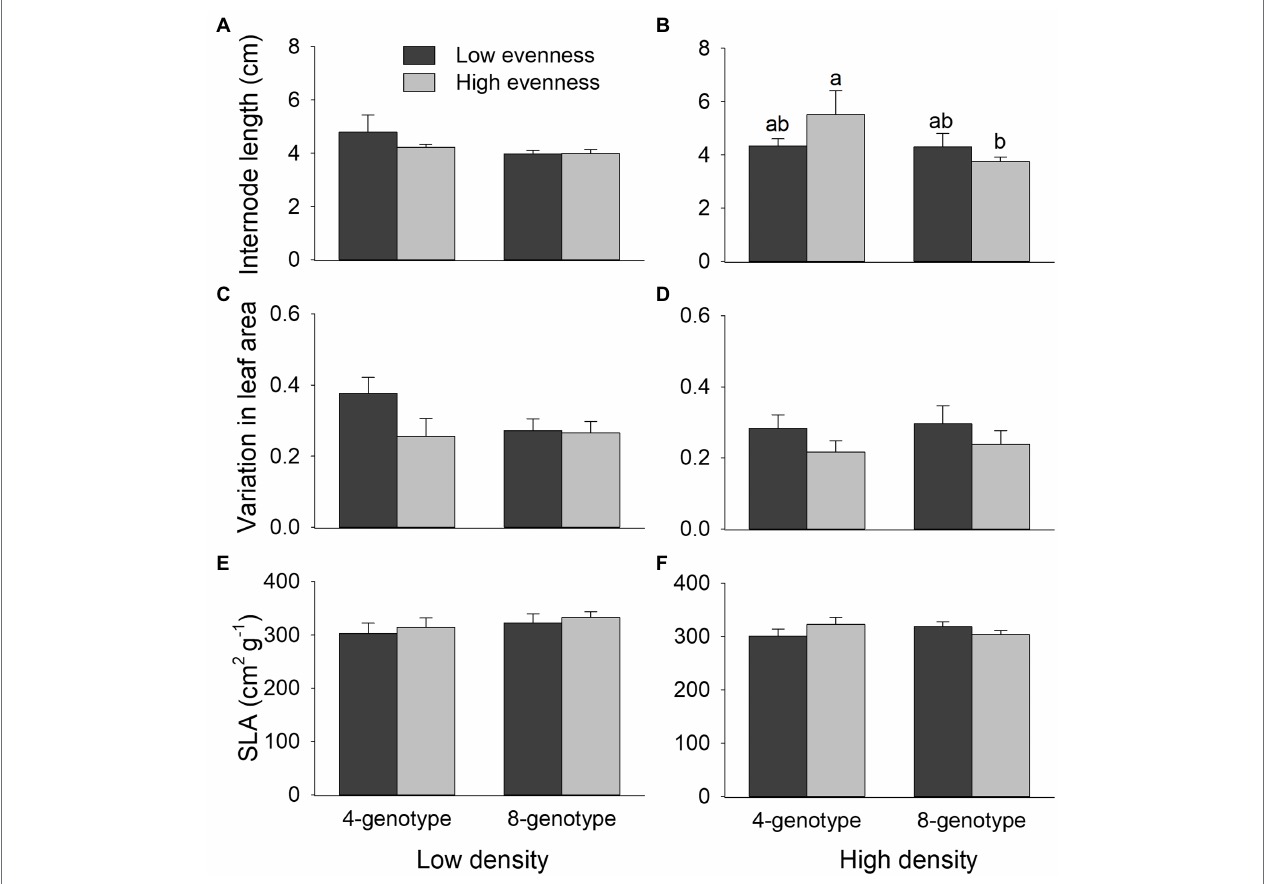
FIGURE 4 | Effects of genotypic richness (4-gneotype vs. 8-genotype), genotypic evenness (low vs. high evenness), and plant density (low vs. high density) on internode length (A,B) , variation in leaf area (C,D) , and specific leaf area (SLA; E,F ) of Hydrocotyle vulgaris population. Mean values (+1 SE) are presented; see Table 1 for statistic results. Different letters (a–b) at the end of bars indicate significant difference in each panel.